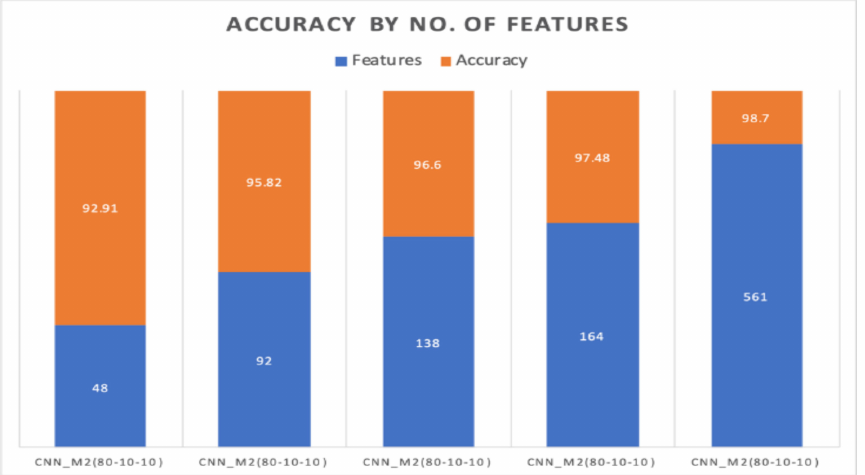
Figure 19. Accuracy by number of features for 80–10–10%. Here, Figure 20 shows the time taken to train the model by using the top features as well as all the